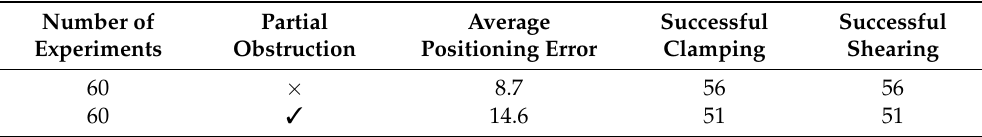
Table 4. The results of the experiments for automatic